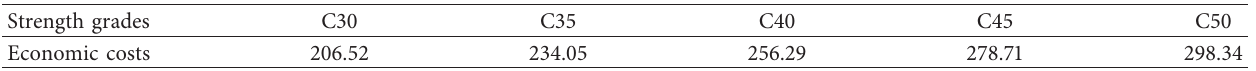
Table 5: Cost of different strength grades coal gangue-based geopolymer concrete (yuan/m 3 ) (before optimization). Strength grades